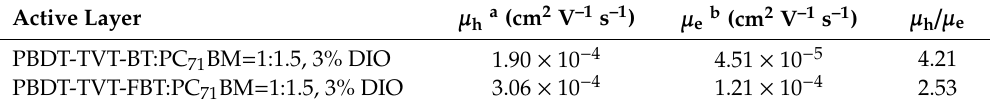
Table 4. Mobilities and µ h / µ e ratio of the studied polymers PBDT-TVT-BT and PBDT-TVT-FBT. Active Layer